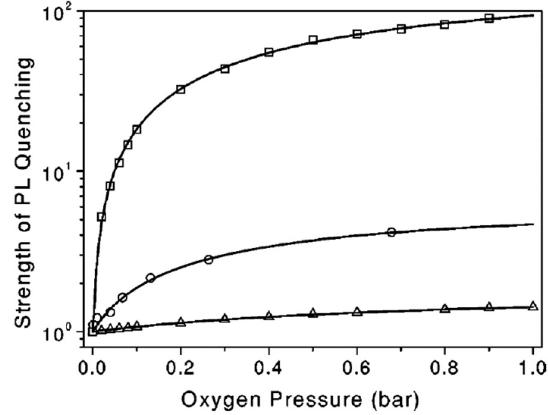
Figure 27. Dependences of the exciton PL quenching strength at 1.63 eV on oxygen pressure at different temperatures: T = 120 K (squares), T =200 K (circles), T =300 K (triangles). Solid lines are fits by Equation (18). (From Reference [65]).